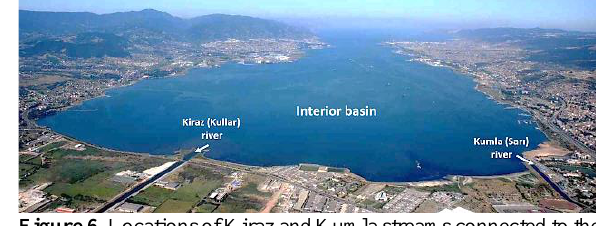
Figure 6. Locations of Kiraz and Kumla streams connected to the interior